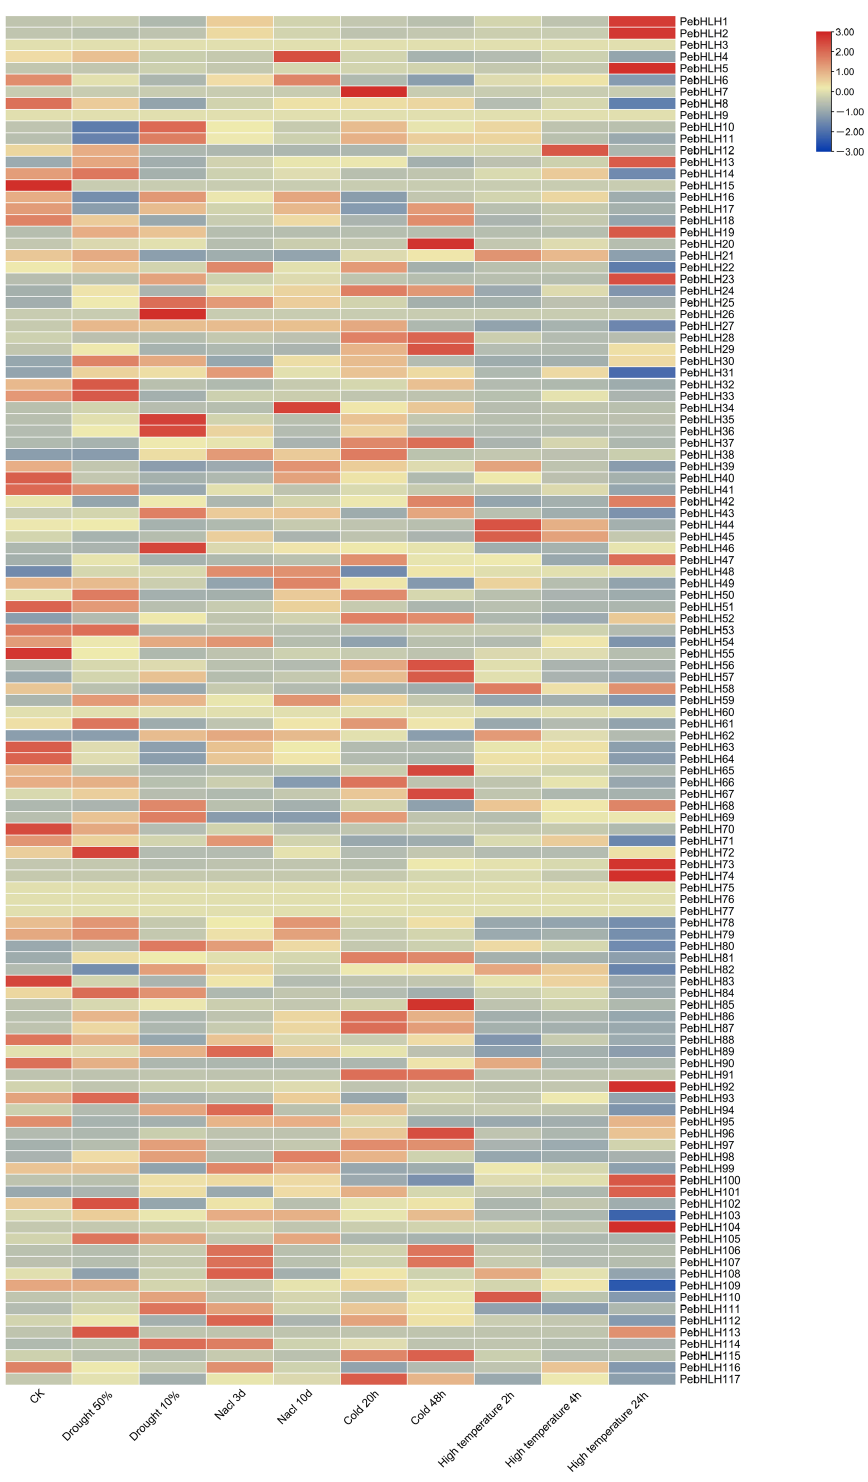
Figure 7. Differential expression of PebHLHs responding to different levels of drought, high salt, cold, and high temperature (Table S2). CK is normal growth condition, drought 50% and 10% are soil water content indexes, NaCl 3 d and 10 d are the treatment time under 300 mM concentration, cold 20 h, and 48 h are the treatment under 8 ◦ C, and high temperature 2 h, 4 h, and 24 h are the treatment time under 42 ◦ C,